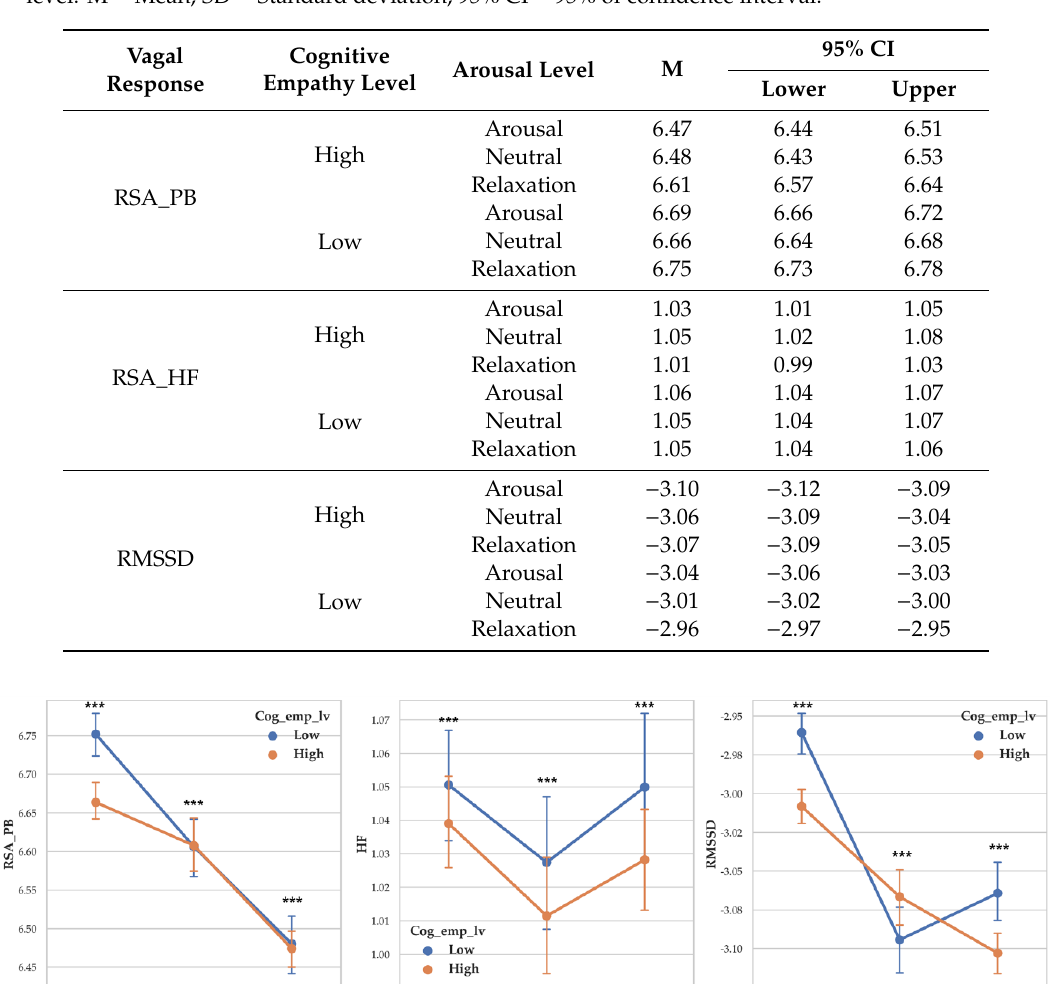
Table 5. Descriptive statistics of vagal response depending on cognitive empathy level and arousal level. M = Mean, SD = Standard deviation, 95% CI = 95% of confidence interval. Vagal Response Cognitive Empathy Level Arousal Level